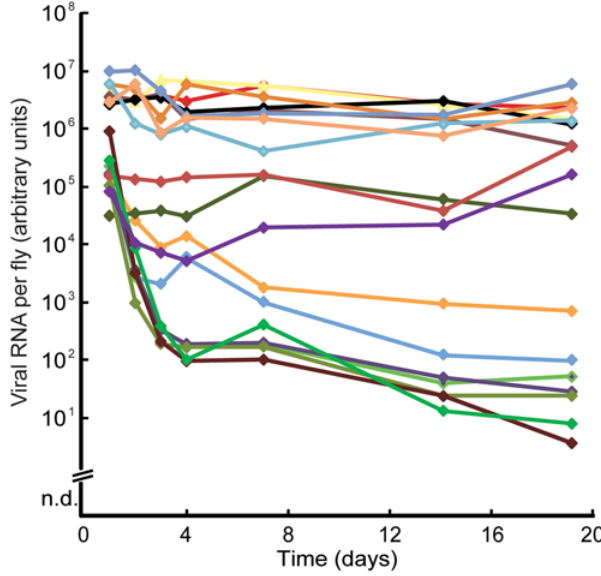
Figure 2. Clearance is threshold-dependent. Viral RNA secreted during 24 hrs in feces of single flies, serially transferred to clean food. Every line represents a single fly followed during 19 days. n.d: not